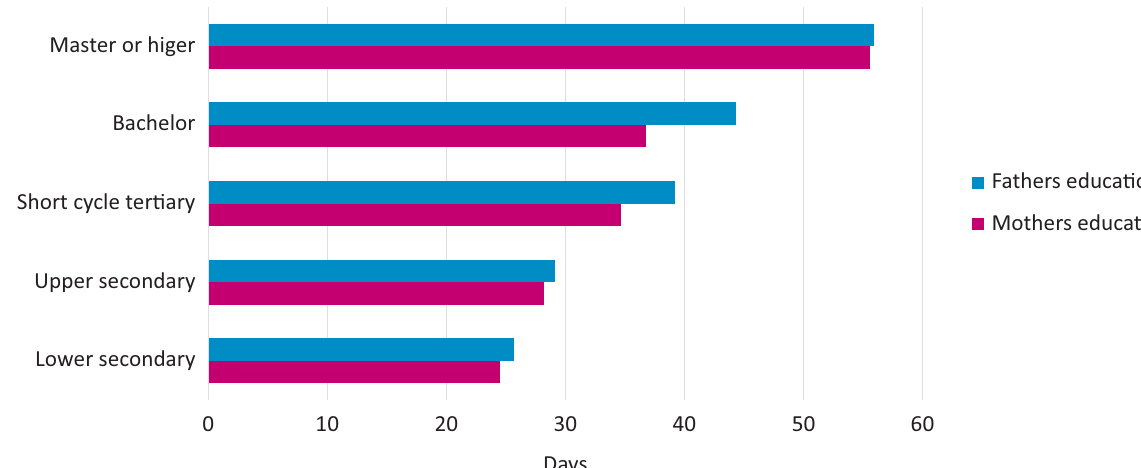
Figure 7. Fathers parental leave take-up (days) by education level (Denmark, 2018). Notes: Cohabiting couples only; both mother and father have taken parental leave. Source: Statistic Denmark